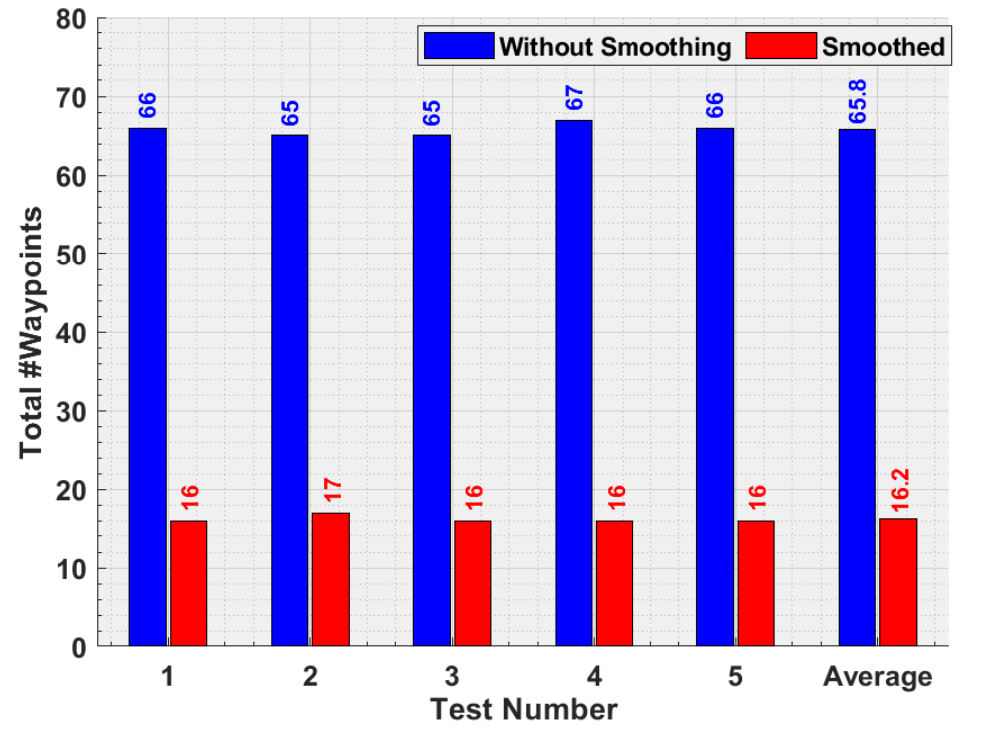
Figure 10. Comparison of total waypoints for original paths and 3D smoothed paths for a swarm of 5